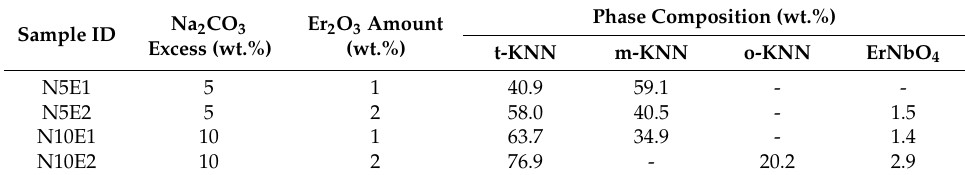
Table 3. Phase composition and crystallographic structure of obtained KNN